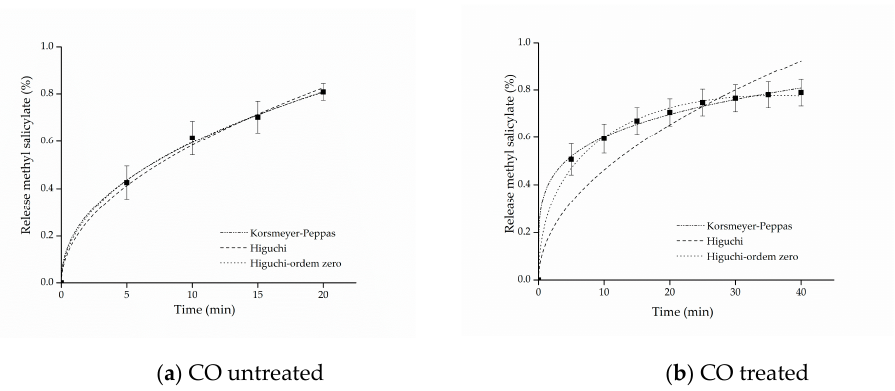
Figure 6. Kinetic adjustments of the profiles of controlled release from ( a ) cotton (CO) untreated and ( b ) CO treated.